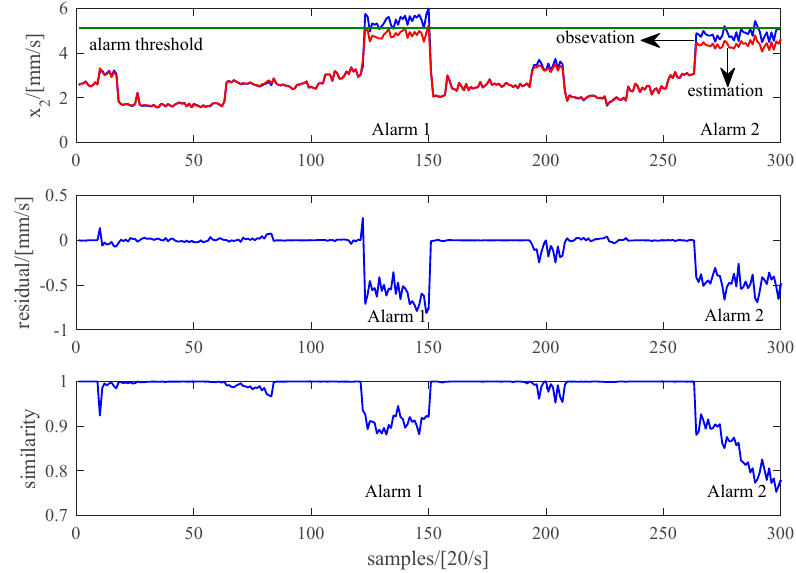
Figure 9. Process of typical vertical vibration alarm Figure 9. process of typical vertical vibration alarm event.